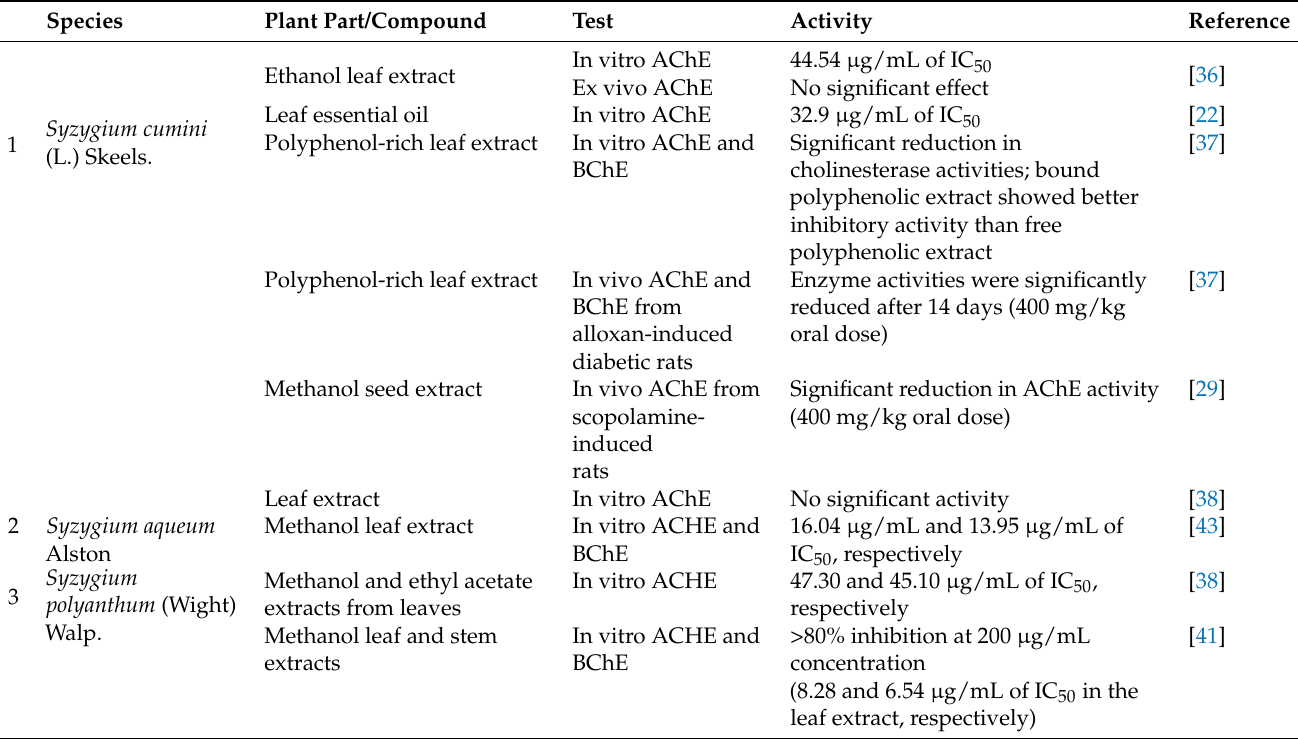
Table 1. Summary of anti-cholinesterase activities exerted from Syzygium